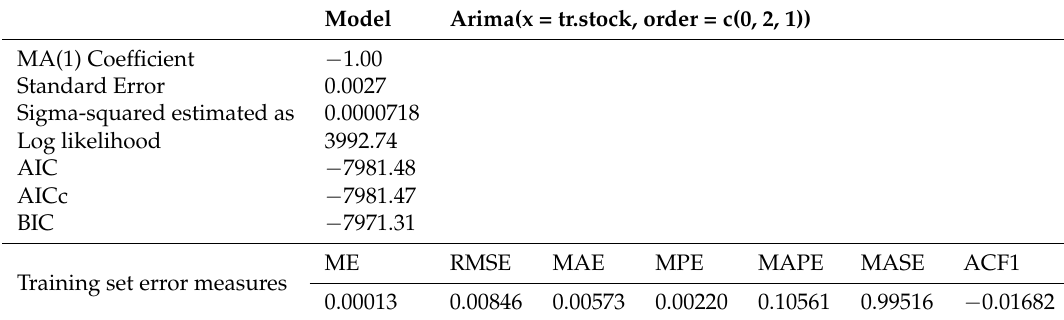
Table 2. ARIMA(0,2,1) model